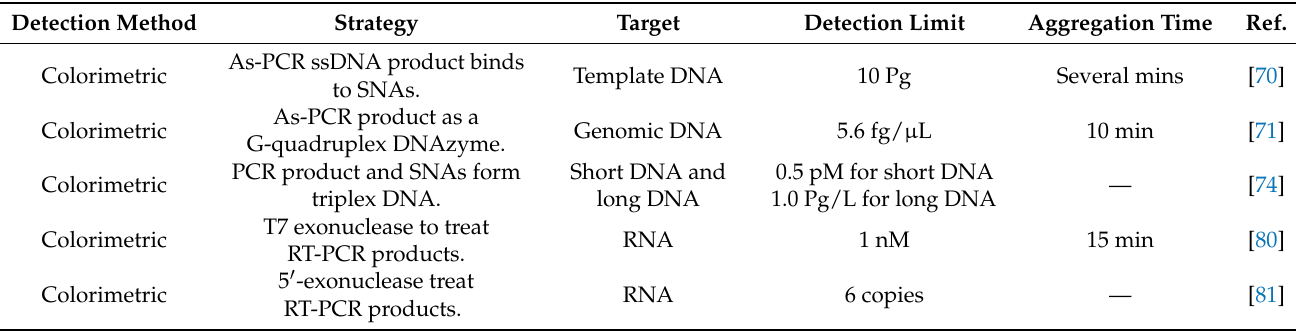
Table 2. Comparison of specific combinations of SNAs in post-processing of PCR product.